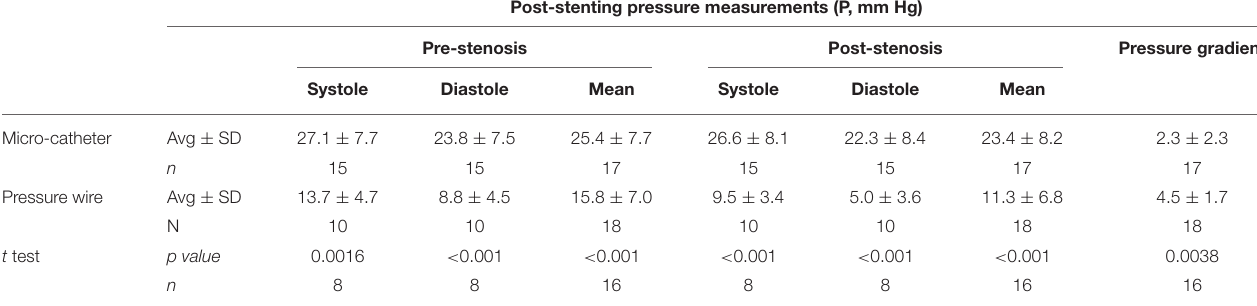
TABLE 3 | Venous pressure measured with the microcatheter and the pressure wire